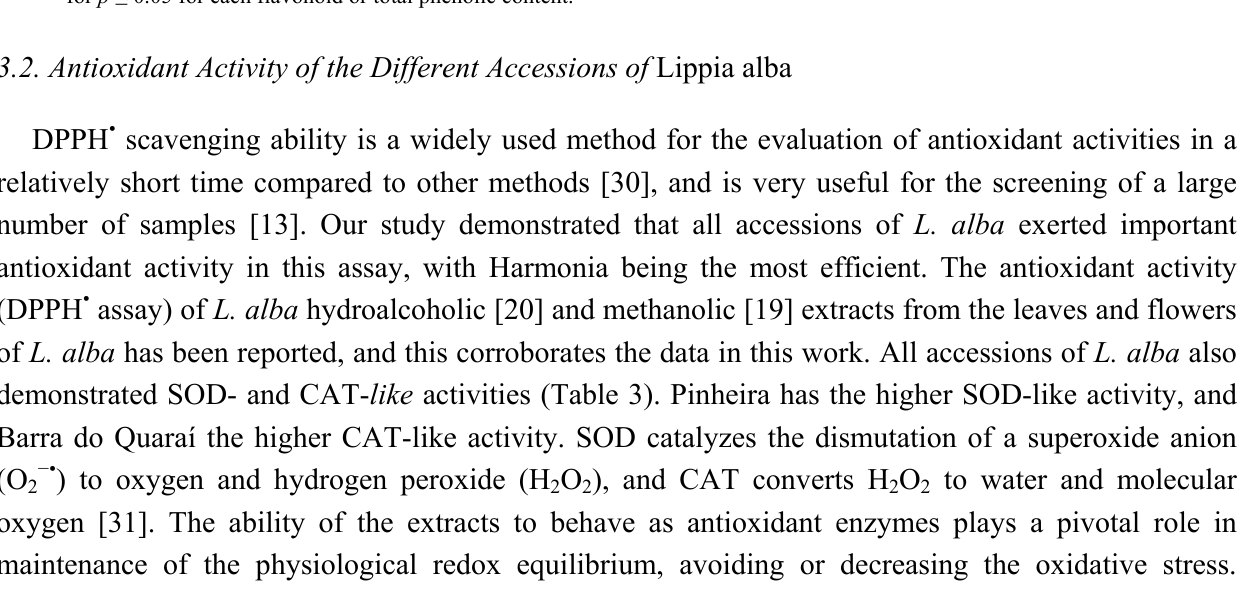
Different letters correspond to values significantly different by analysis of variance (ANOVA) and Tukey’s post hoc test for p ≤ 0.05 for each flavonoid or total phenolic